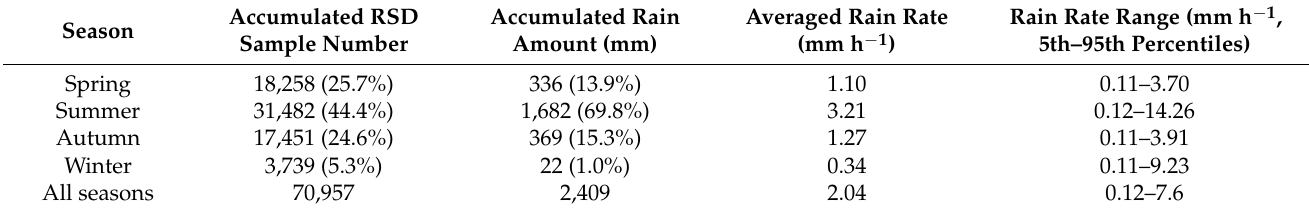
Table 1. Accumulated RSD sample number, accumulated rain amount, average rain rate, and rain rate ranges (5th to 95th percentiles) in four seasons during 2018–2020. The percentage against the all-seasons value is shown in parentheses, and rain rates herein were calculated from 1 min RSD using Equation